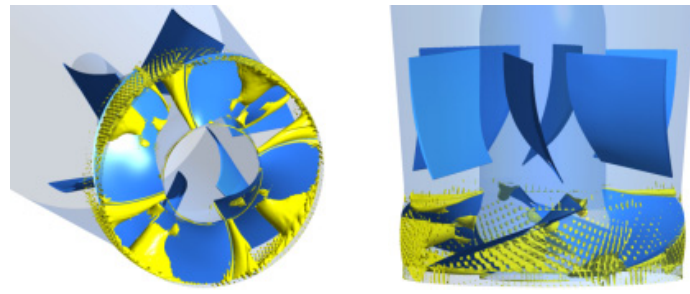
Figure 9. Area of sheer stress exceeding the threshold in the impeller.